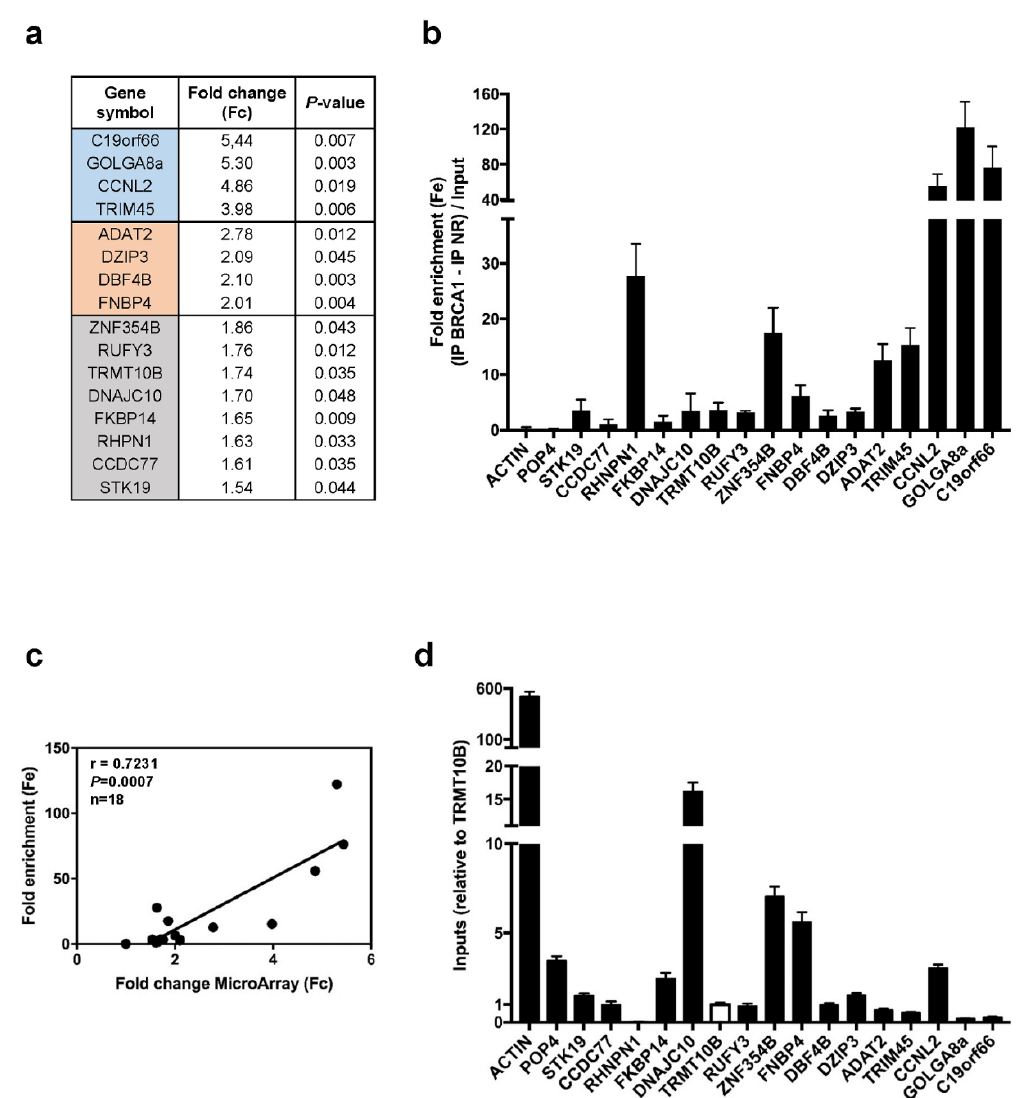
Figure 2. Analysis of a representative subset of BRCA1-associated mRNAs. RIP of three new independent replicates followed by RT-qPCR. ( a ) Subset of 16 BRCA1-associated mRNAs spanning the full range of Fc observed in Figure 1b. Colors indicate the range of Fc obtained by microarray. ( b ) Fold enrichment (Fe) of the 16 BRCA1-associated mRNAs determined by RT-qPCR. Data are expressed as means ± SEM. n = 3. ( c ) Correlation between Fc calculated from the A ff ymetrix array and Fe measured by RT-qPCR. Mean RIP fold change obtained by microarray (Fc) and mean RIP fold enrichment obtained by RT-qPCR (Fe) were plotted and their correlation was assessed using the Spearman test. A significant correlation was observed. ( d ) Quantification by RT-qPCR of each BRCA1-associated mRNA in total extracts of MCF-7 cells (inputs). The TRMT10B value was arbitrarily set at 1 (white bar). Data are expressed as means ± SEM. n = 3.